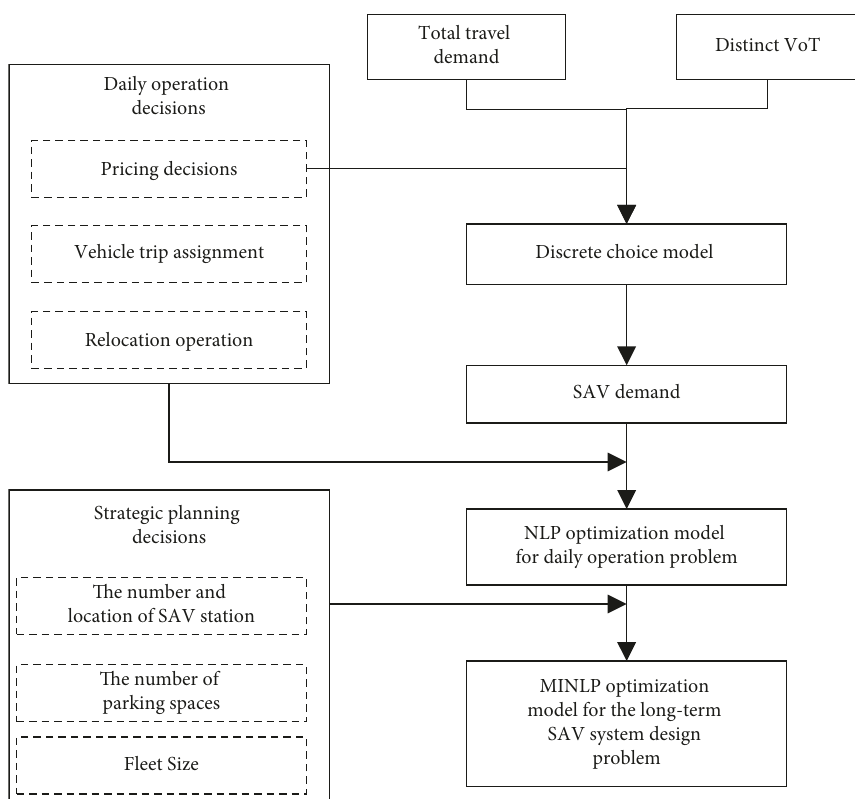
Figure 1: Flowchart of the modeling